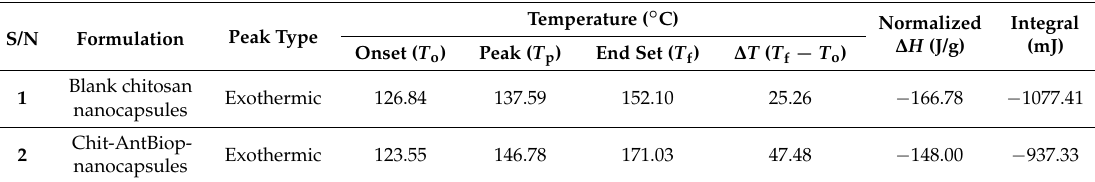
Figure 3. Physical appearance, in vitro release profiles and differential scanning calorimetry (DSC) of the Chit-AntBiop-NPs; ( a ) transmission electron microscopy (TEM) images of Chit-AntBiop-NPs, ( b ) In vitro release profiles of AntBiop from Chit-AntBiop-NPs in PBS pH 7.4 ( c ) DSC curve of the blank chitosan nanoparticles and ( d ) DSC curve of the Chit-AntBiop-NPs. Table 1. Changes in the enthalpies obtained from DSC thermograms of blank Chitosan nanocapsules and Chit-AntBiop-nanocapsules.